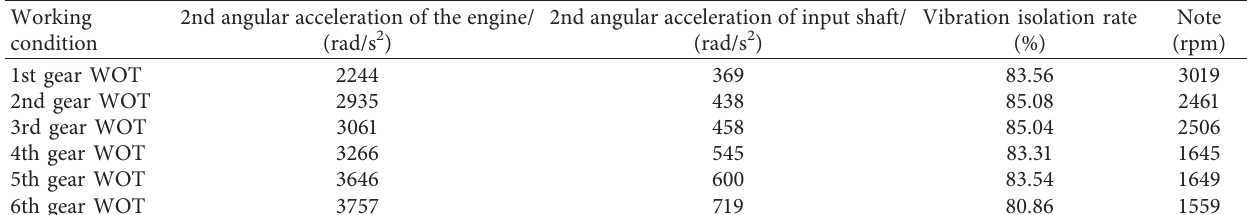
Figure 18: Schematic diagram of arc spring. Table 4: Actual test results of sample loading.